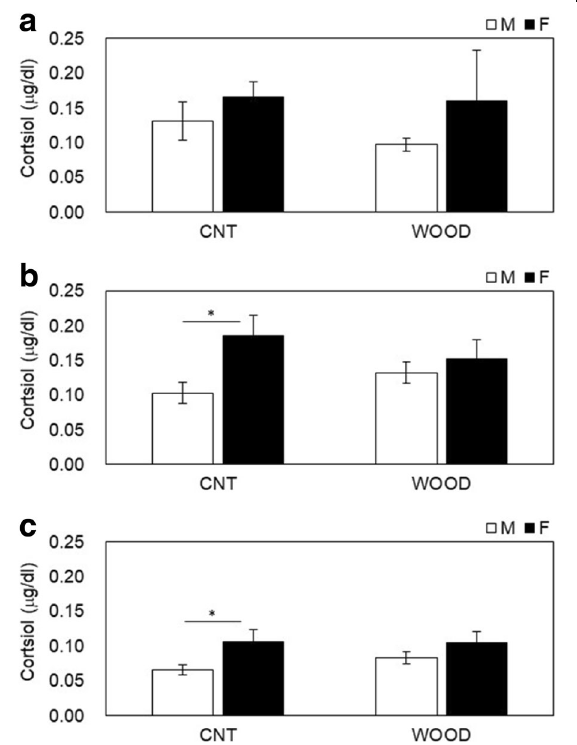
Fig. 5 Variation of salivary cortisol levels changes at a pre-, b during, and c post-experiment measurements. The bars in a – c show changes in the salivary cortisol levels of participants in the control condition (left) and Japanese cedar wood panels (experimental; light) conditions: male participants (white) and female participants (black). CNT indicates the control condition, while WOOD indicates the experimental condition. The bars in a show that differences between conditions were not significant. The bars in b show that the difference in values between male and female participants were significant ( p =0.013) in the control condition. The bars in c show that the difference in values between the male and female participants was significant ( p =0.027) in the control condition. *statistical significance ( p <0.05). Data are